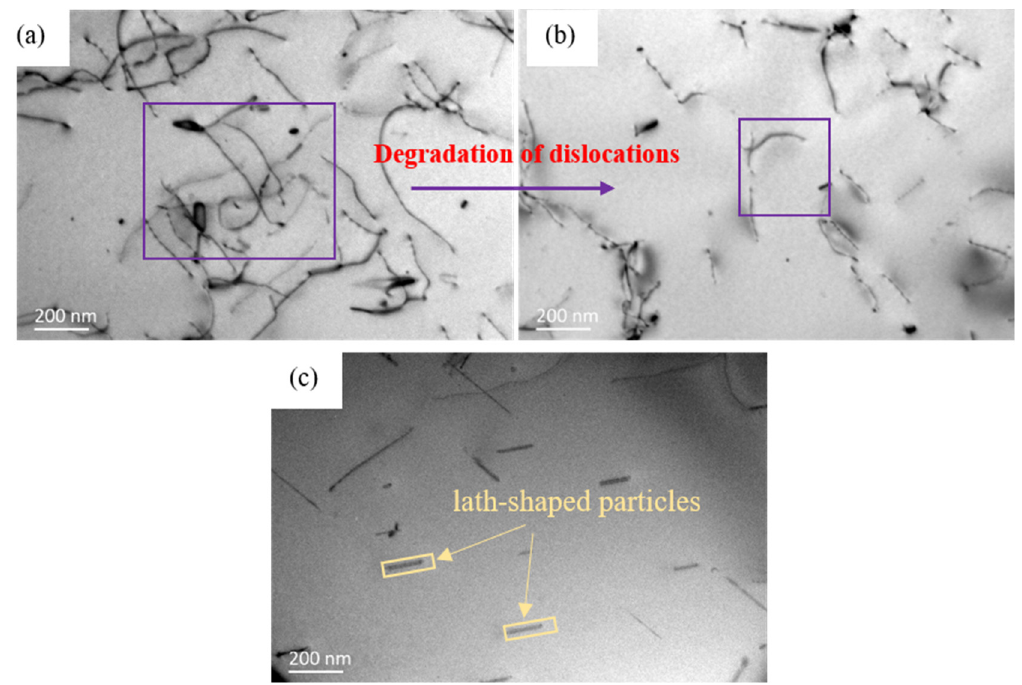
Figure 4. TEM micrographs of Al-4Mg alloy aged for ( a ) 1 h, ( b ) 8 h, ( c ) 32 h at 210 °C, respec- tively.